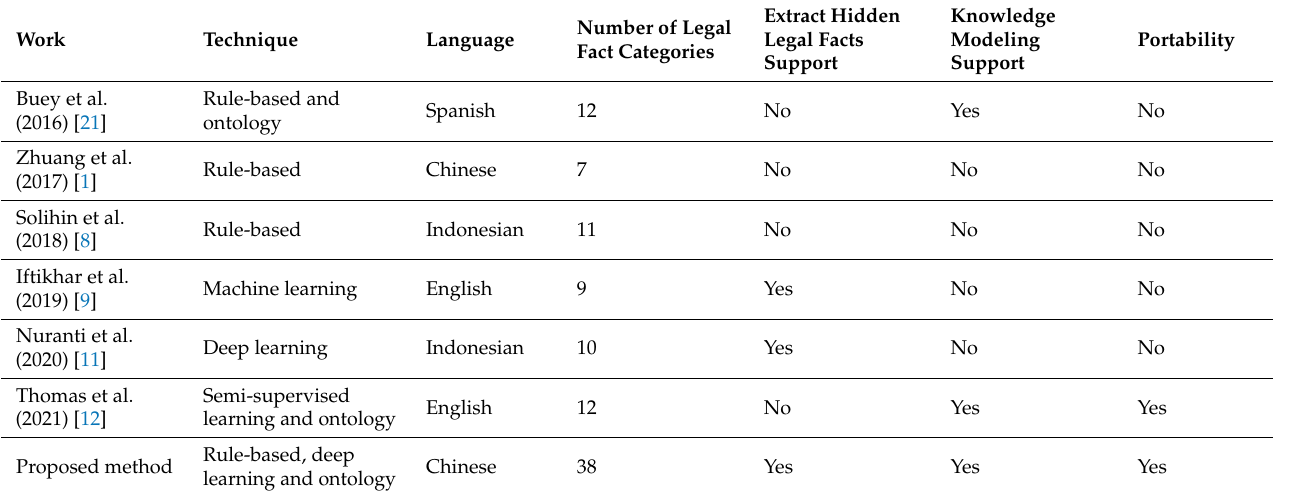
Table 7. Comparison of the proposed method and other related